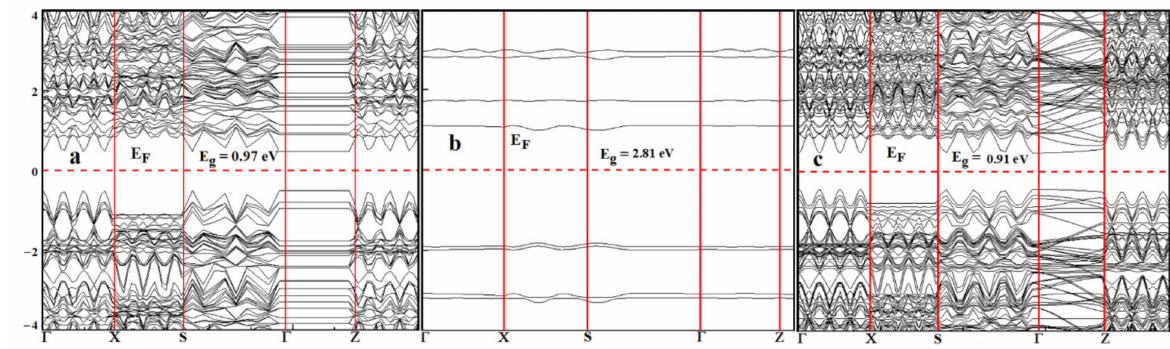
Figure 6. Band structure of ( a ) phosphorene, ( b ) thioguanine, and ( c ) phosphorene–thioguanine complex.